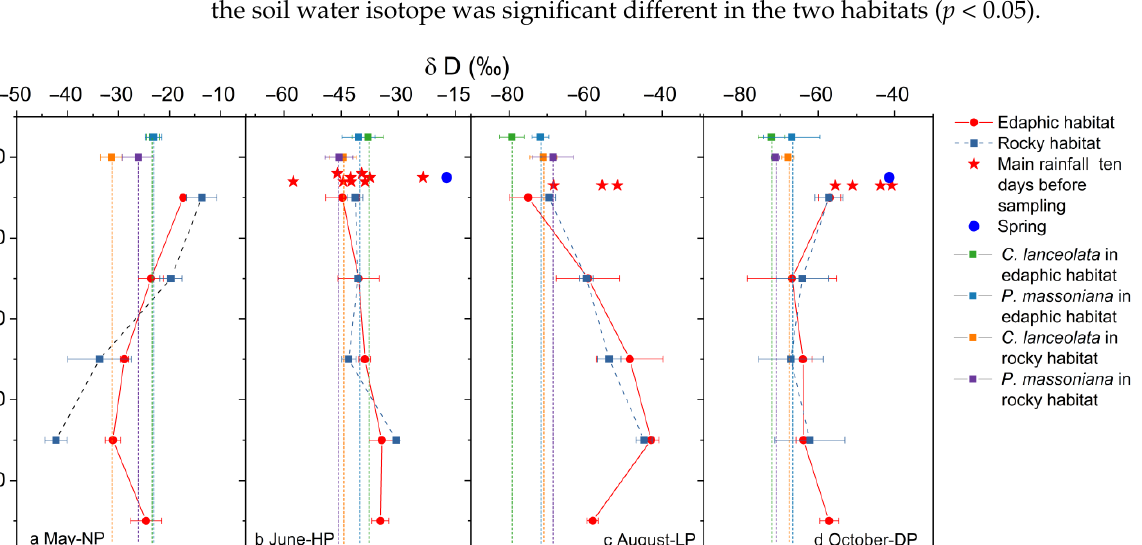
Figure 4. Variation in mean (±S.D.) δ 18 O of soil water with the soil profile, precipitation, spring, and xylem water during the wet season ( a ) May sampling; ( b ) June sampling; ( c ) August sam- pling; ( d ) October sampling). 3.2. Variations in Soil Water Content, Water Uptake Patterns, and Their Linkage with Precipita- tion The VWCs of the two habitats displayed clear vertical and seasonal variations (Fig- ure 5). The average VWCs were 43.42% ± 7.68% in the edaphic habitat and 38.24% ± 8.42% in the rocky habitat, with no significant differences ( p = 0.07) during the study periods. However, the VWCs of shallow soil layers in the two habitats differed significantly ( p < 0.001). In NP, the VWC of the shallow layer was the lowest in the two habitats and the